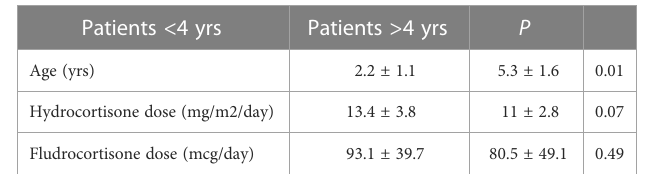
TABLE 2 Patients ’ characteristics and suspected episodes of adrenal crisis in the study